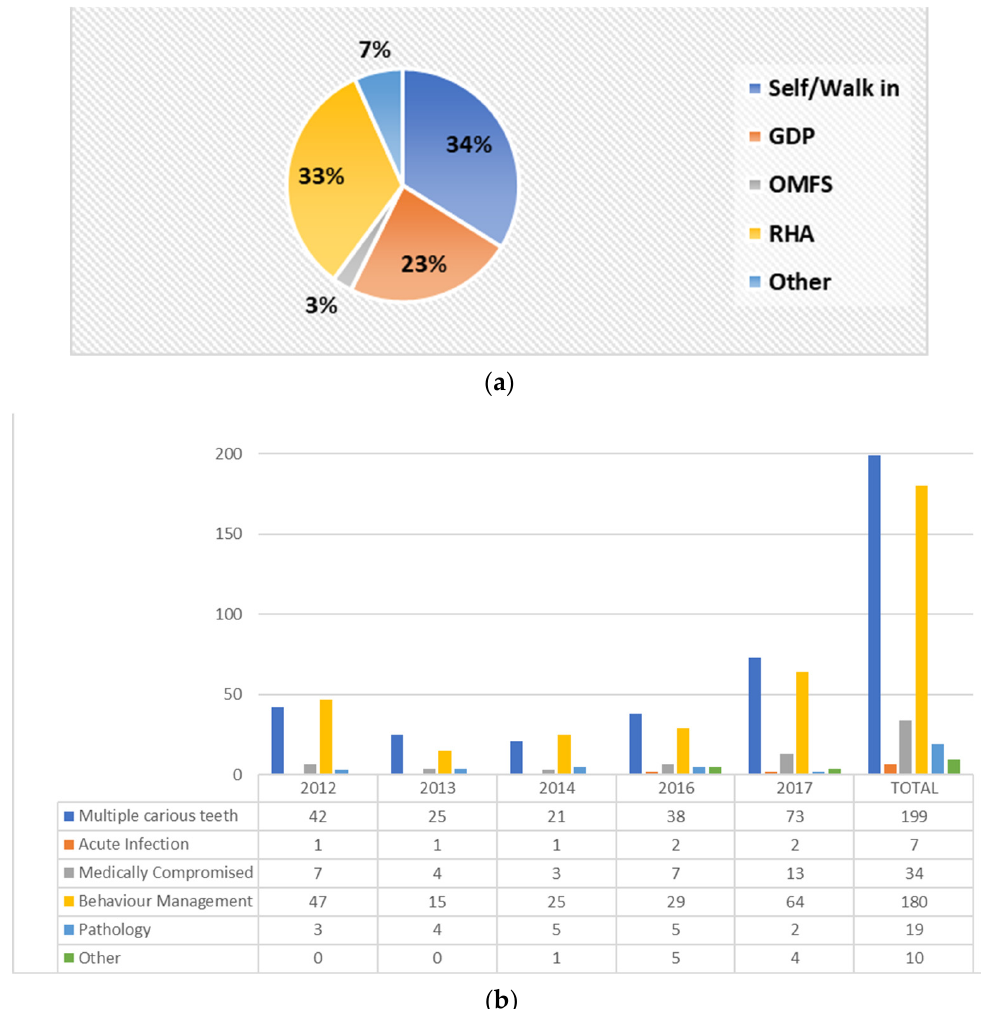
Figure 2. ( a ) Source of referral to CDHU (%); ( b ) chart representing reasons for referral for GA/se- dation. GDP—general dental practitioner; OMFS—oral and maxillofacial surgery; RHA—Regional Health Au- dental practitioner; OMFS—oral and maxillofacial surgery; RHA—Regional Health thority.